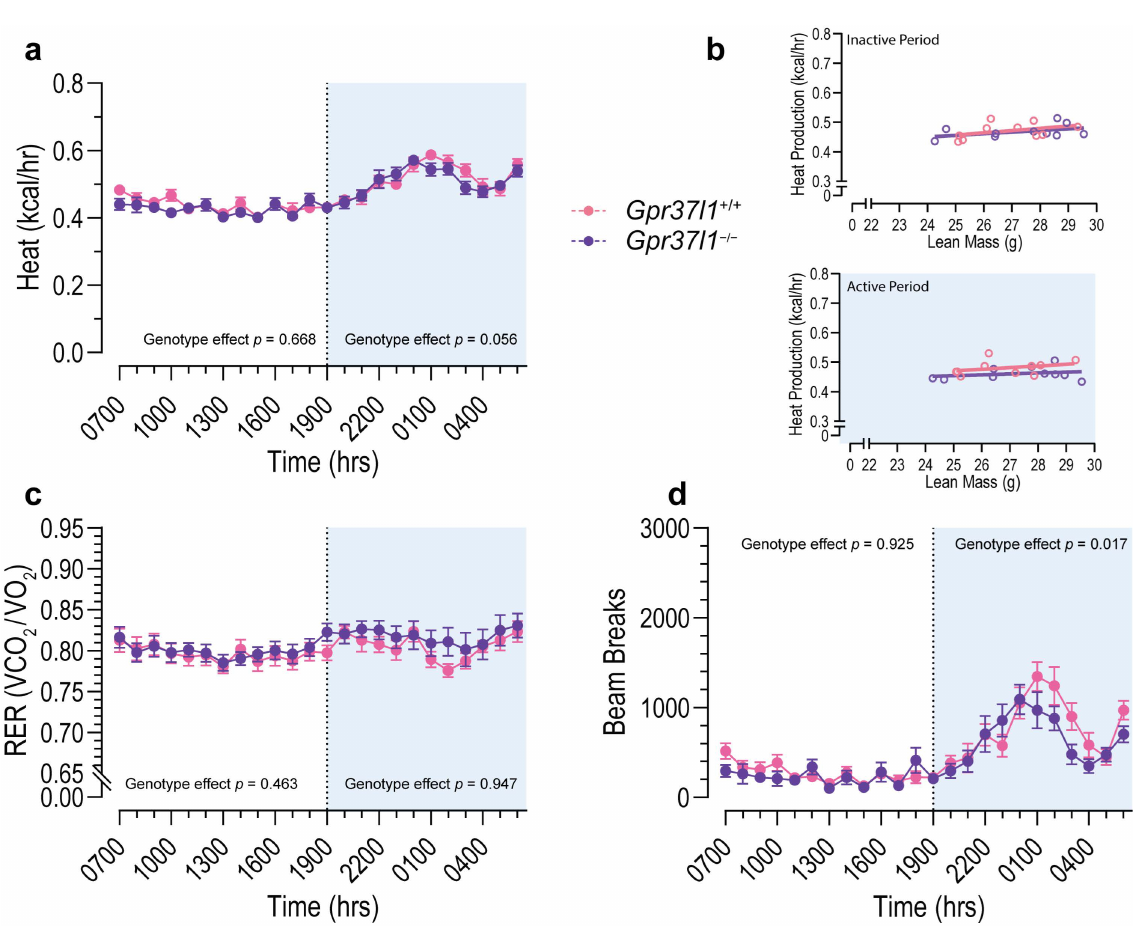
Figure 7. Metabolic profiling of aged Gpr37l1 − / − and Gpr37l1 +/+ mice by indirect open-circuit calorimetry. At 51 weeks of age, male Gpr37l1 − / − and wildtype ( Gpr37l1 +/+ ) littermates were subjected to metabolic profiling using the Comprehensive Lab Animal Monitoring System (CLAMS). Mice were acclimated in the system for 24 h, followed by a 24 h period of data collection. Oxygen/CO 2 readings were taken every 10–13 min. ( a ) Heat production and ( c ) respiratory exchange ratio (RER) were derived from these measurements, and were processed into hourly averages. ( b ) Average heat production vs. lean mass for inactive (top panel) and active (bottom panel) periods. ( d ) Physical activity was measured by the number of infrared beam breaks in the XZ plane. Solid circles represent hourly averages for each experimental group; open circles represent individual subjects; error bars indicate SEM. Data analysed by repeated measures two-way ANCOVA (for a ; lean mass covariate) or by repeated measures ANOVA ( c , d ) within each dark/light period (12 h). Significance was defined as p < 0.05 and denoted by bolded p value. Time is denoted in standard military time format; light period 0700–1900 (7 a.m.–7 p.m.). n = 10 for each group, 20 weeks